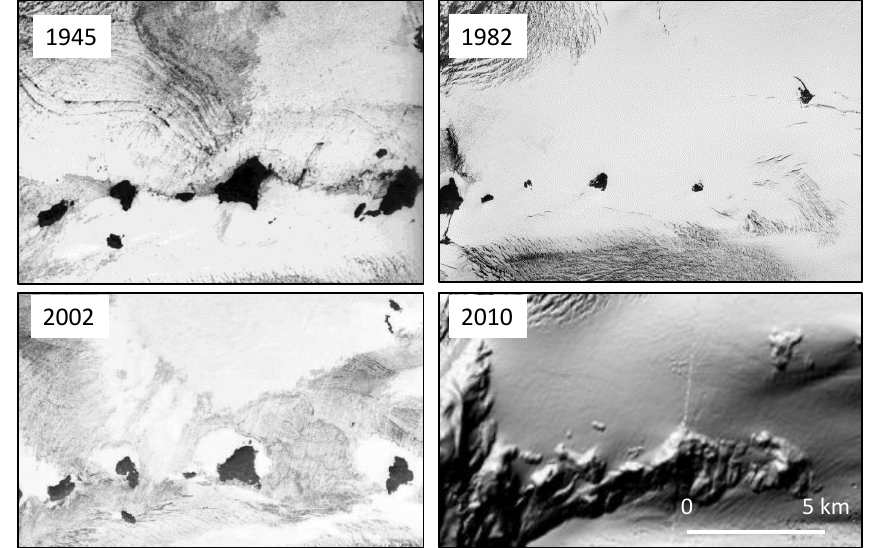
Figure 3. Small nunataks at an elevation of 950–1050m, east of the mountain “Skerið milli skarða”, which divides the main branch of Skaftafellsjökull (see Fig. 5), at different times. Aerial photograph of the National Land Survey of Iceland 1945 and 1982, aerial image of Loftmyndir ehf. from 2002, lidar shaded relief map from 2010. Only the largest mid-nunatak is visible on the 1904 map (not